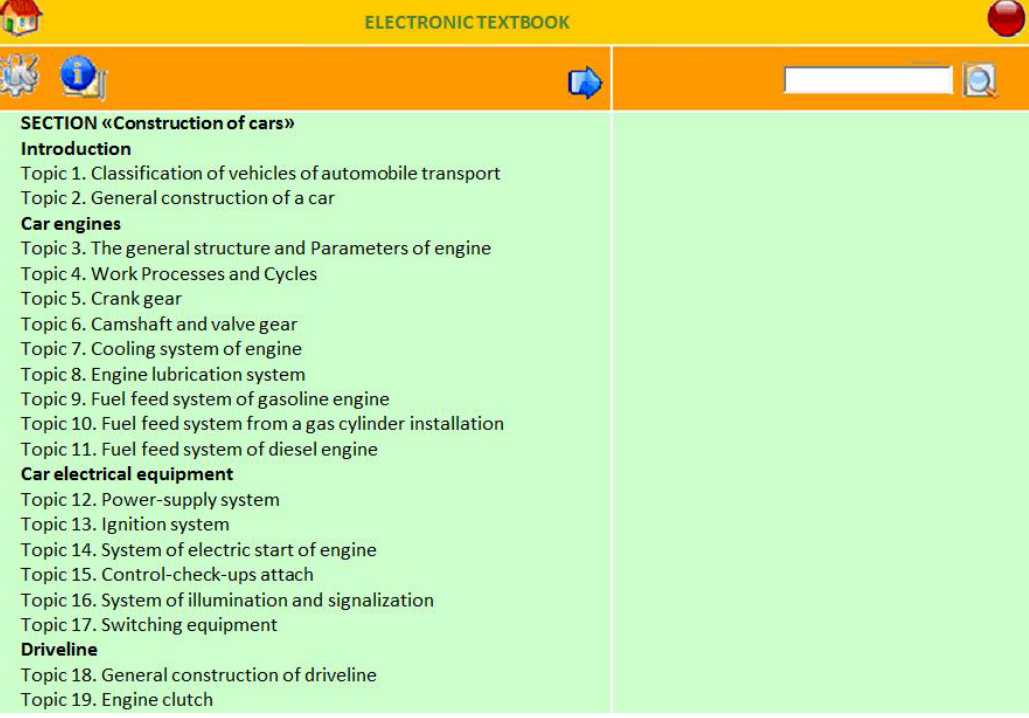
Figure 60: Presentation of paper